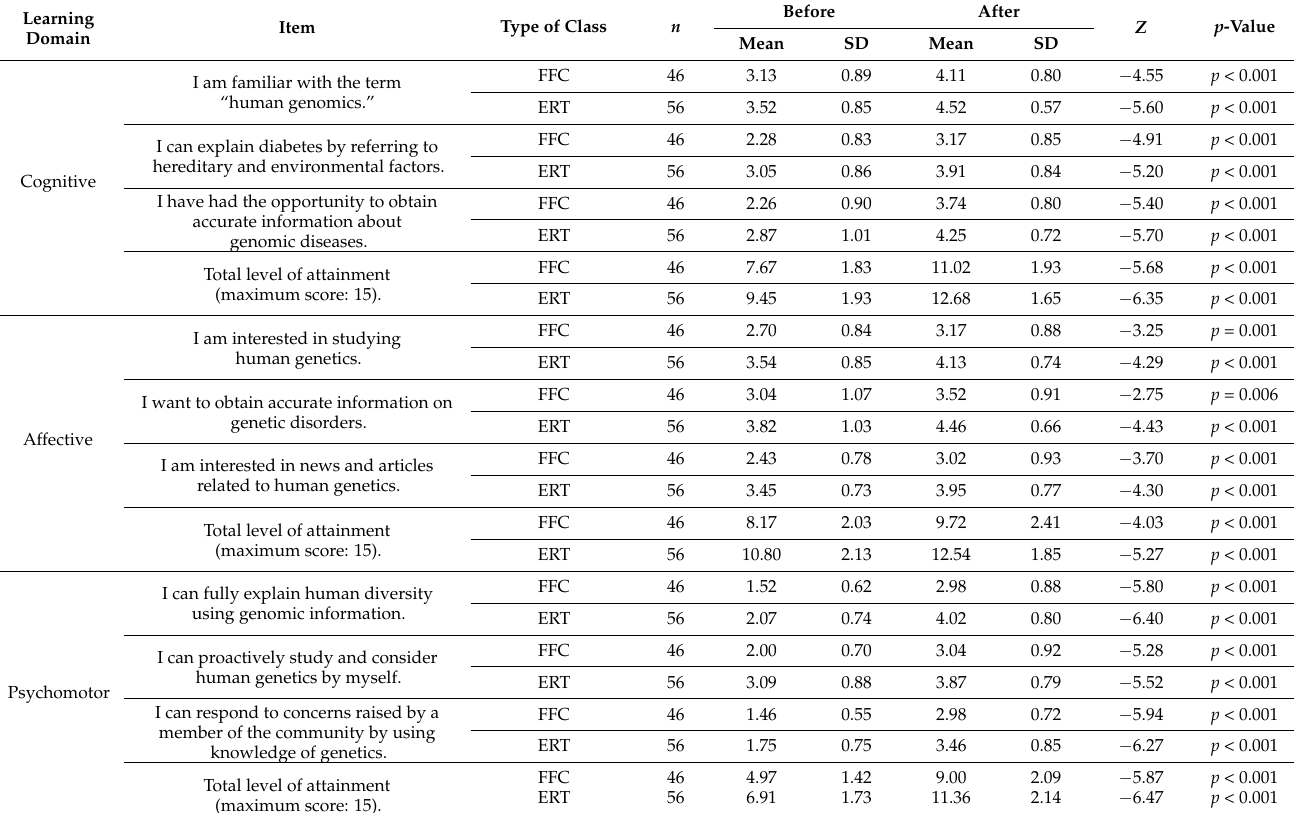
Table 1. Changes in mean scores for goal attainment by type of